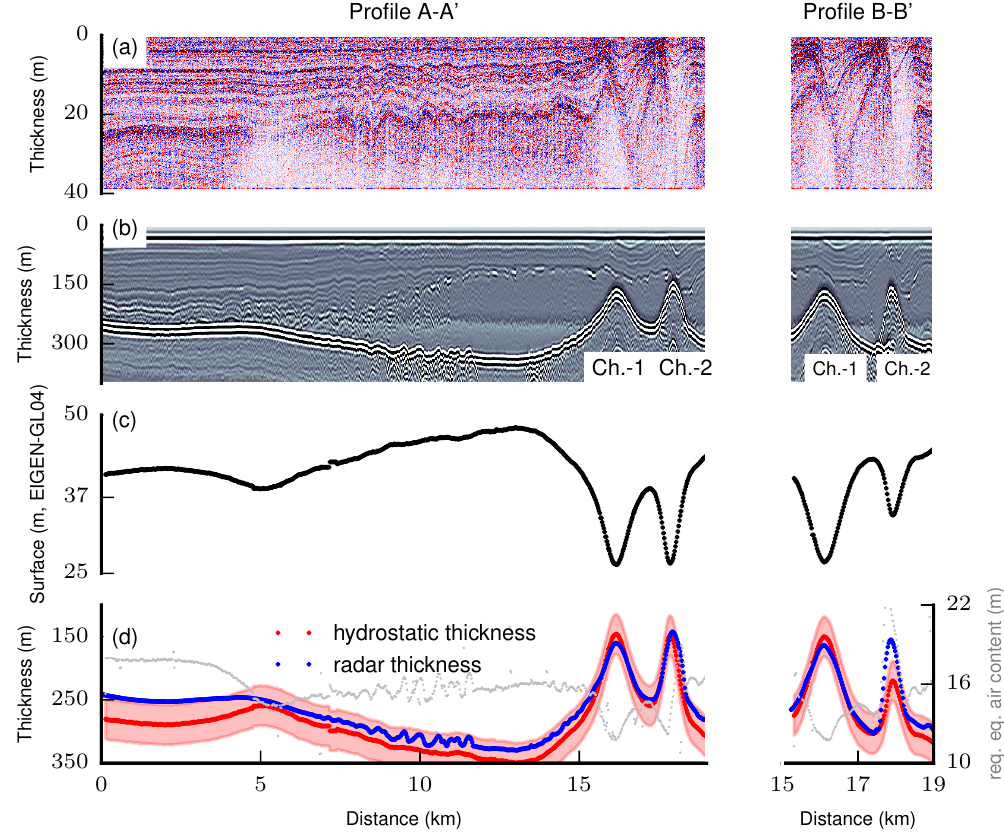
Figure 5. Observations for two channels (Ch.-1, Ch.-2) along profiles A-A’ and B-B’ (Fig. 1) are shown for the 400 MHz data in (a) and for the 10 MHz data in (b) . Based on the surface profile (c) , radar and hydrostatic thickness in (d) agree within the error bounds except for Ch.-2 along B-B’ where the hydrostatic thickness is anomalously larger. The gray curve shows the required changes in the equivalent air content to obtain hydrostatic